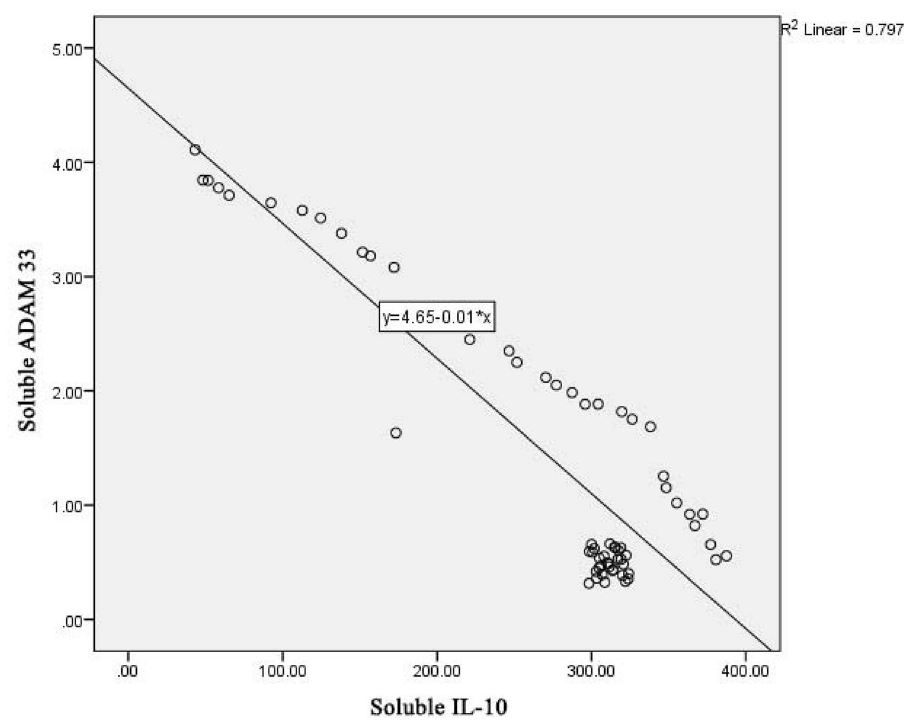
Figure 5. Linear regression graph between IL-10 and ADAM33 level in COPD